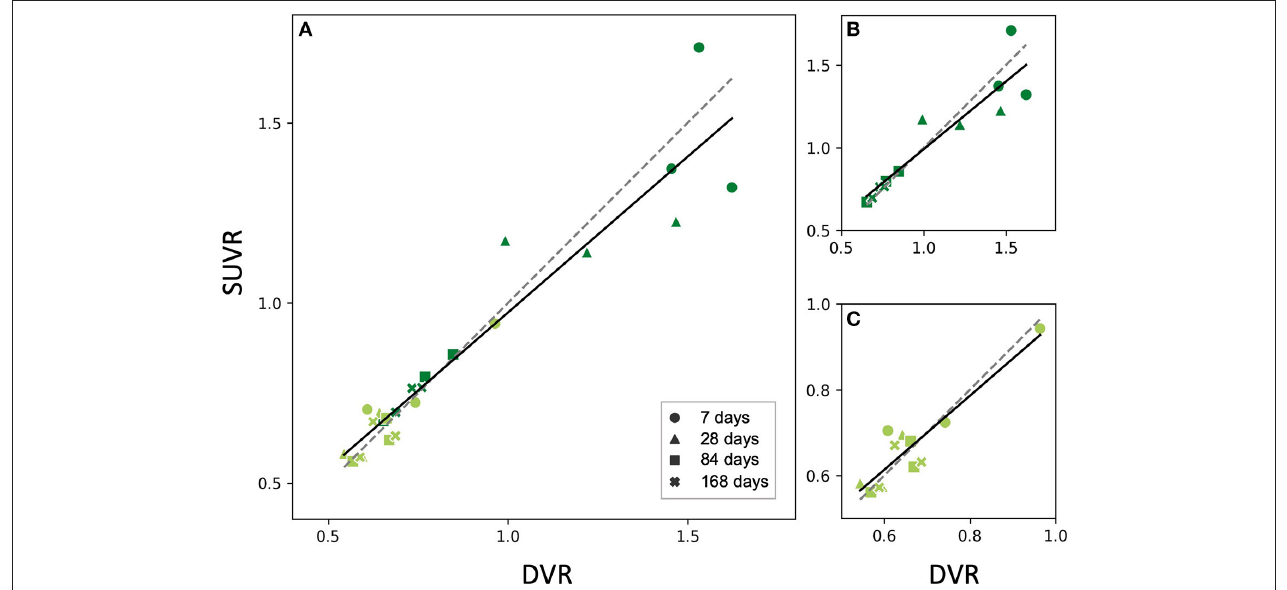
FIGURE 5 | Relationship between SUVR and DVR from the static 60–90min scan in the PT VOI of the studied mice (all time points). Dark green dots indicate PT mice, light green dots represent sham mice (A) PT and sham mice together, fit parameters: SUVR = 0.87 • DVR + 0.11, r = 0.95, p < 10 − 12 , (B) PT mice only, fit parameters: SUVR = 0.82 • DVR + 0.17, r = 0.92, p < 10 − 4 , (C) Sham mice only, fit parameters: SUVR = 0.86 • DVR + 0.10, r = 0.91, p = 10 − 4 . All the fits (solid lines) are close to identity line (dashed). The marker shape represents the time after the